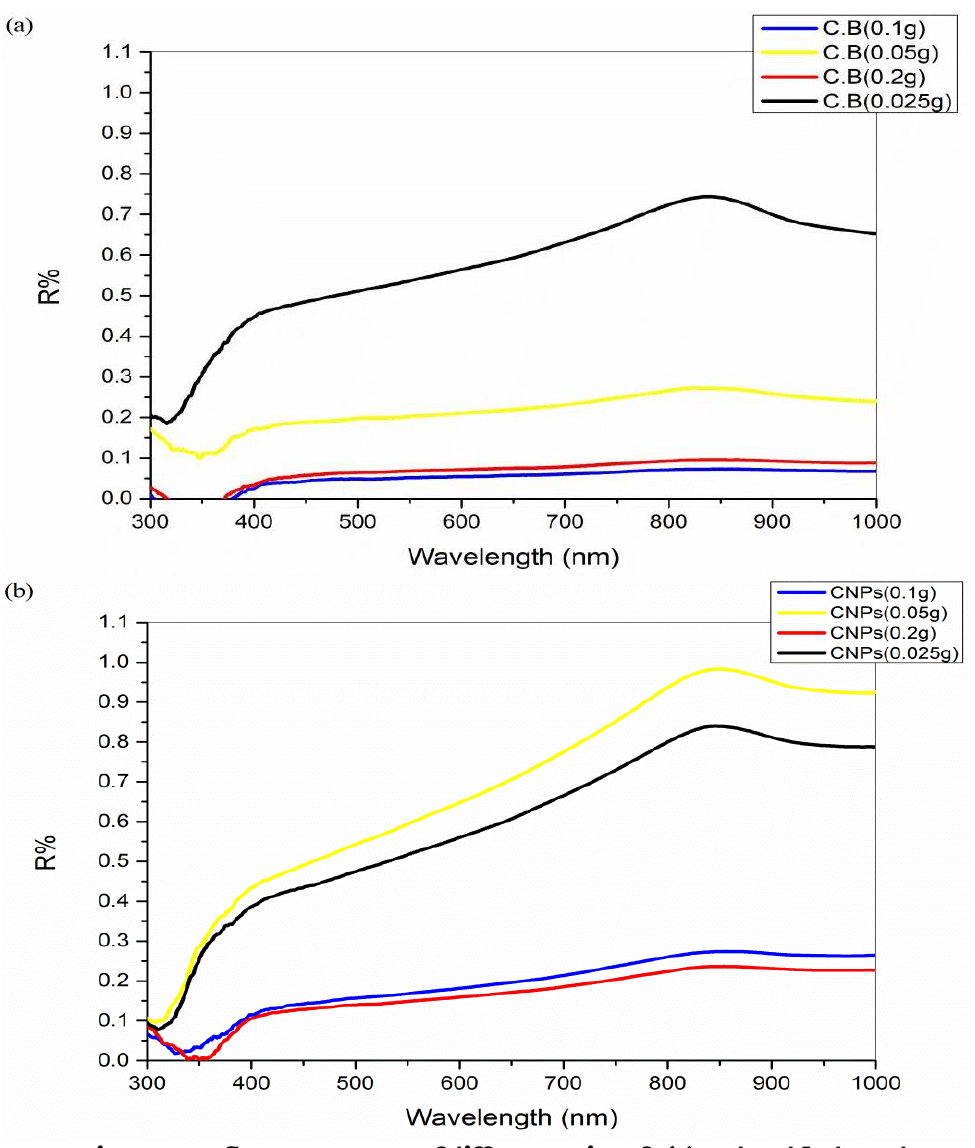
Figure 3: Reflectance spectra of different ratios of: (a) carbon black, and (b) carbon nanoparticles with silicon glue